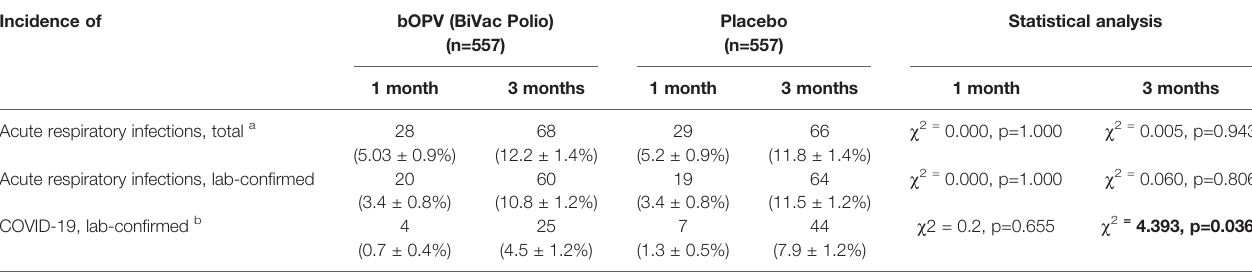
TABLE 4 | Cases of COVID-19 and other acute respiratory illnesses in bOPV recipient and placebo groups. Incidence of bOPV (BiVac